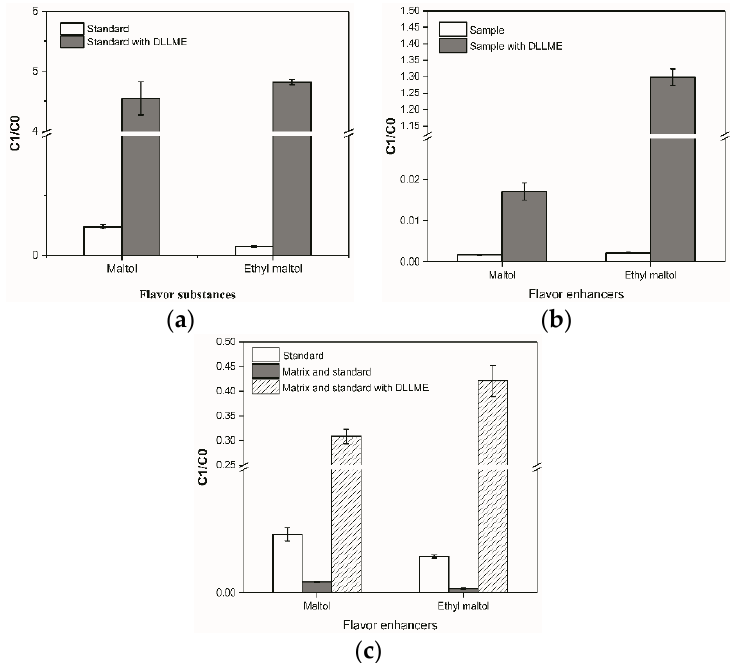
Figure 3. Effects of different pretreatments (without DLLME treatment and after DLLME treatment) on extraction efficiency of maltol and ethyl maltol: ( a ) Effect of DLLME treatment on the extraction efficiency of maltol and ethyl maltol standards; ( b ) effect of DLLME treatment on the extraction efficiency of maltol and ethyl maltol in the matrix (dried squid samples); ( c ) effect of DLLME treatment on the extraction efficiency of maltol and ethyl maltol in the matrix with standards. C1/C0, the peak